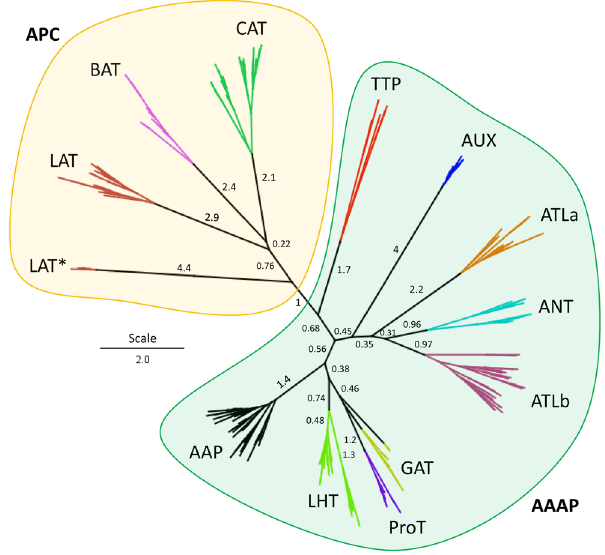
Figure 2. Phylogenetic tree of AAPs. 98 single functional genes of wheat AATs (one from each homeologous group) were aligned with rice and Arabidopsis using protein sequences. This tree was constructed using CLUSTALW and PHYML programs in Geneious. Detailed clustering was shown in Supplementary Fig.